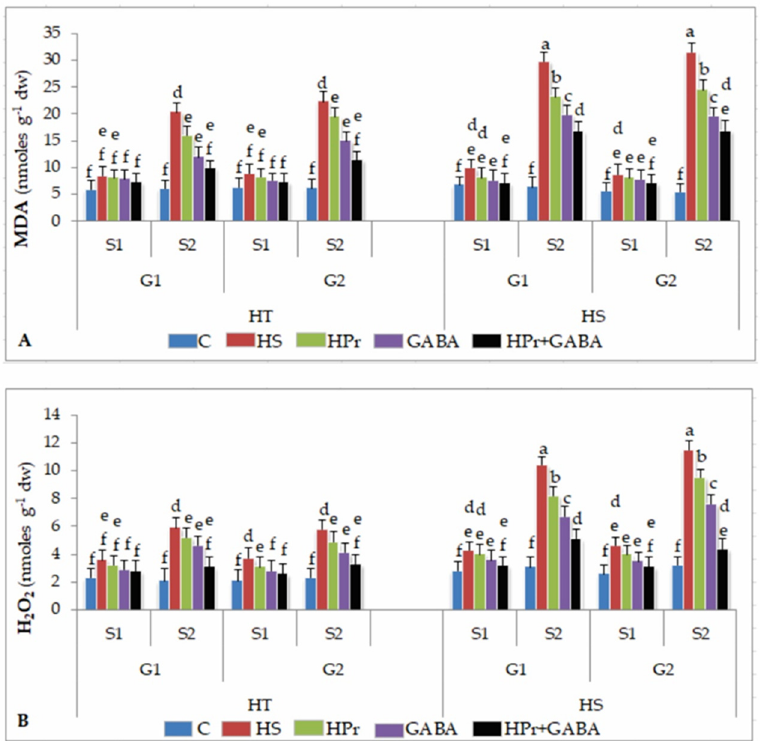
Figure 5. Effect of heat priming (HPr) and γ -amino butyric acid (GABA), applied individually or in combination (HPr+GABA) on malondialdehyde, MDA ( A ) and hydrogen peroxide, H 2 O 2 ( B ) on heat-tolerant (G1: IG2507; G2: IG3263) and heat-sensitive (G1: IG2821; G2: IG2849) genotypes at stage 1 (S1) and stage 2 (S2) in heat-stressed (HS) lentil plants, compared to control ( C ). Vertical bars represent standard errors ( n = 3). Different small letters on the bars indicate significant differences from each other ( p < 0.05). LSD for interaction (genotypes × stages × treatments) ( p < 0.05): malondialdehyde: 1.9, hydrogen peroxide: 0.74. dw = dry